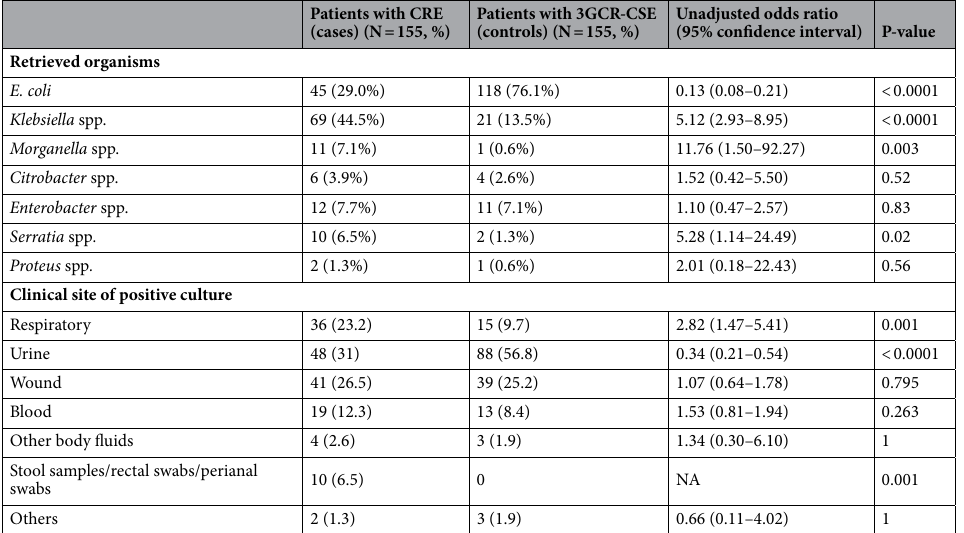
Patients with CRE Patients with 3GCR-CSE (cases) (N = 155, %) (controls) (N = 155, %)